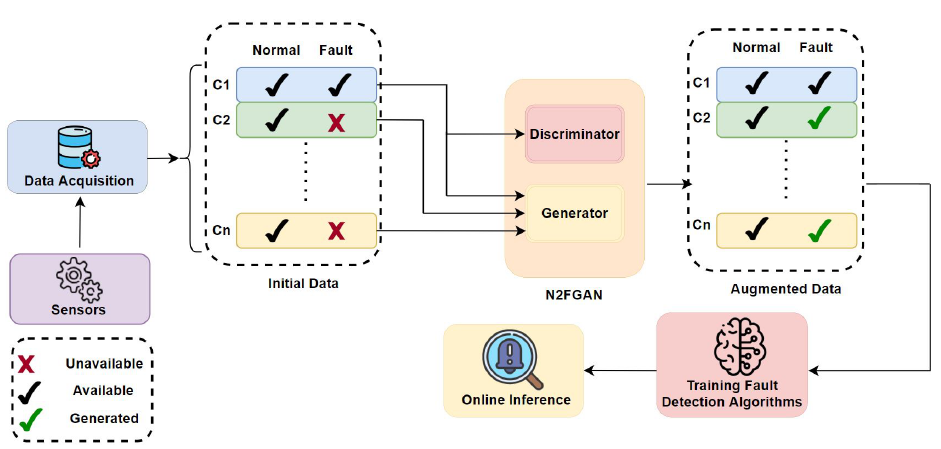
Figure 1. A flow diagram using N2FGAN for fault data